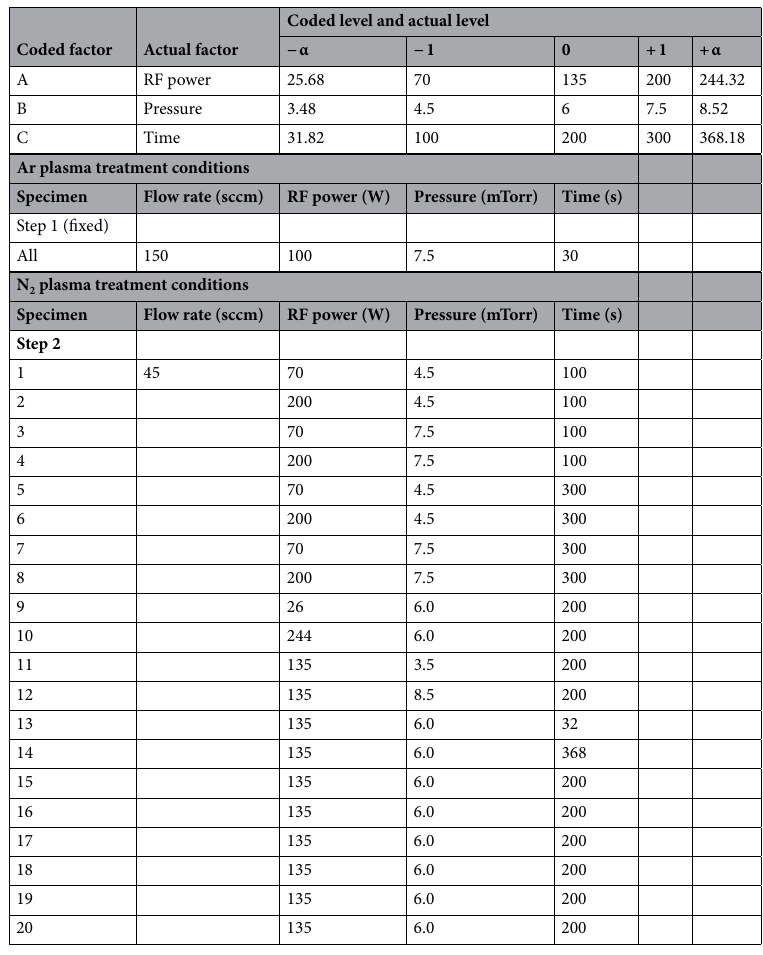
Table 1. Independent factors and levels (coded and actual) for CCD design (top), fixed Ar plasma treatment conditions (middle), N 2 plasma treatment conditions designed by CCD